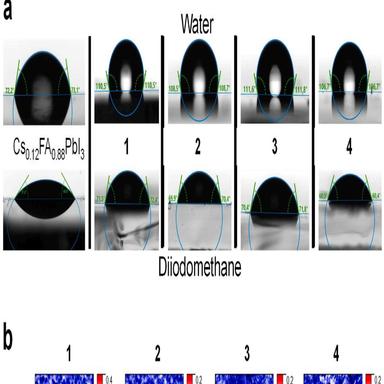
Droplets of diiodomethane and water on the surface of Cs0.12FA0.88PbI3 and Cs0.12FA0.88PbI3/1–4 stacks (a). IR s-SNOM mapping images for Cs0.12FA0.88PbI3/ 1–4 stacks at the frequencies of 1048 cm− 1 characteristic for Cs0.12FA0.88PbI3 and 1650 cm− 1 corresponding to C=O vibration in 1–4.